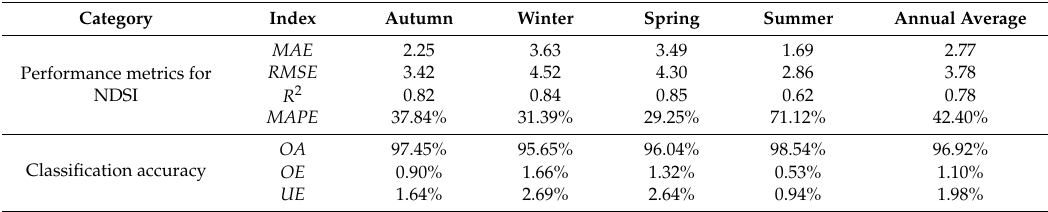
Table 3. Performance metrics for NDSI and the classification accuracy for the similar pixel selecting algorithm